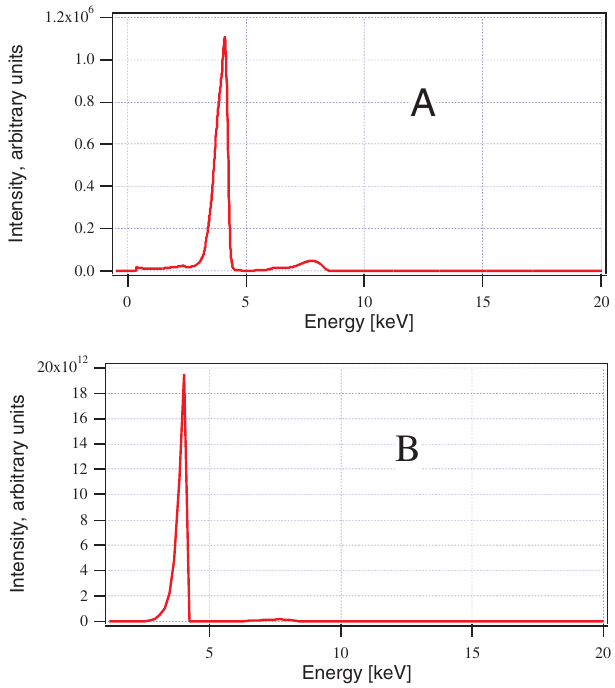
FIG. 8. (Color) Measured spectrum (a) of the emitted x rays and calculated spectrum with XURGENT [15] (assumed parameters: (cid:1) 25 m , (cid:5) (cid:1) 9 m , " (cid:1) 40 nm , " (cid:1) 10 (cid:6) 2 ). The stored =" (cid:5) x y x y x electron beam current was 112 mA and the k value of the undulator was